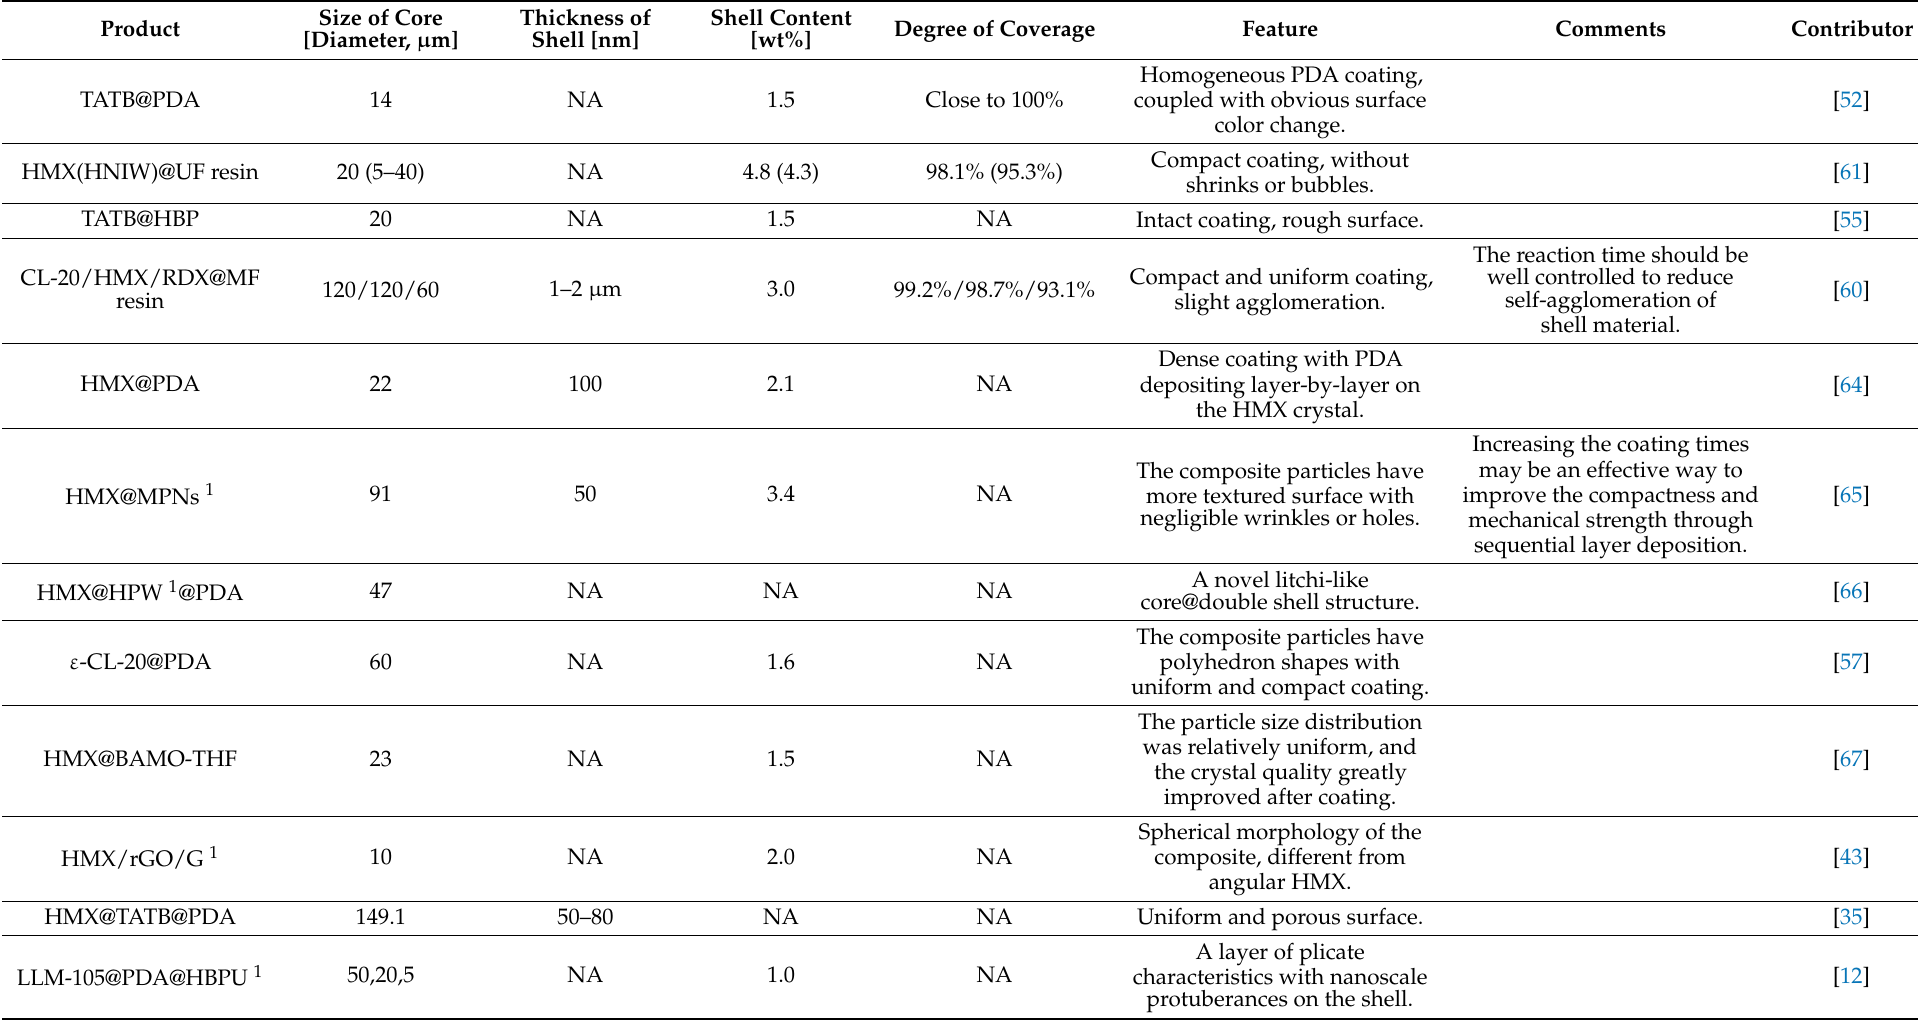
Table 1. Characteristics of the products prepared by in situ polymerization method.